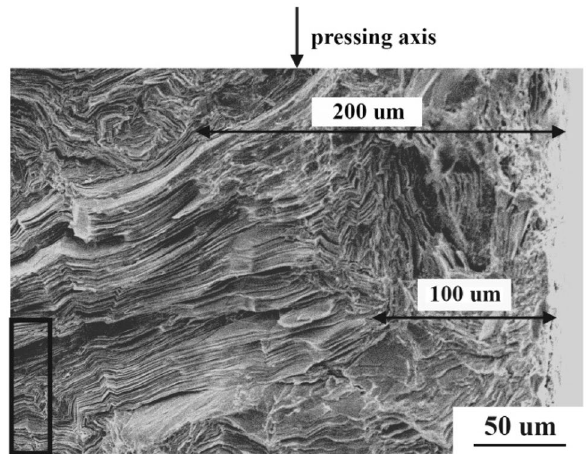
Fig. 1 The cross-sectional SEM image of the semiconductor material sample obtained in the process of hot pressing (the selected fragment is the end of the plate, cut out for the experiment) Fig. 2 The PT chamber ( a ) and the xenon lamp emission spectra of ( b ): 1, a sample; 2, xenon lamps; 3, quartz tubes; 4,